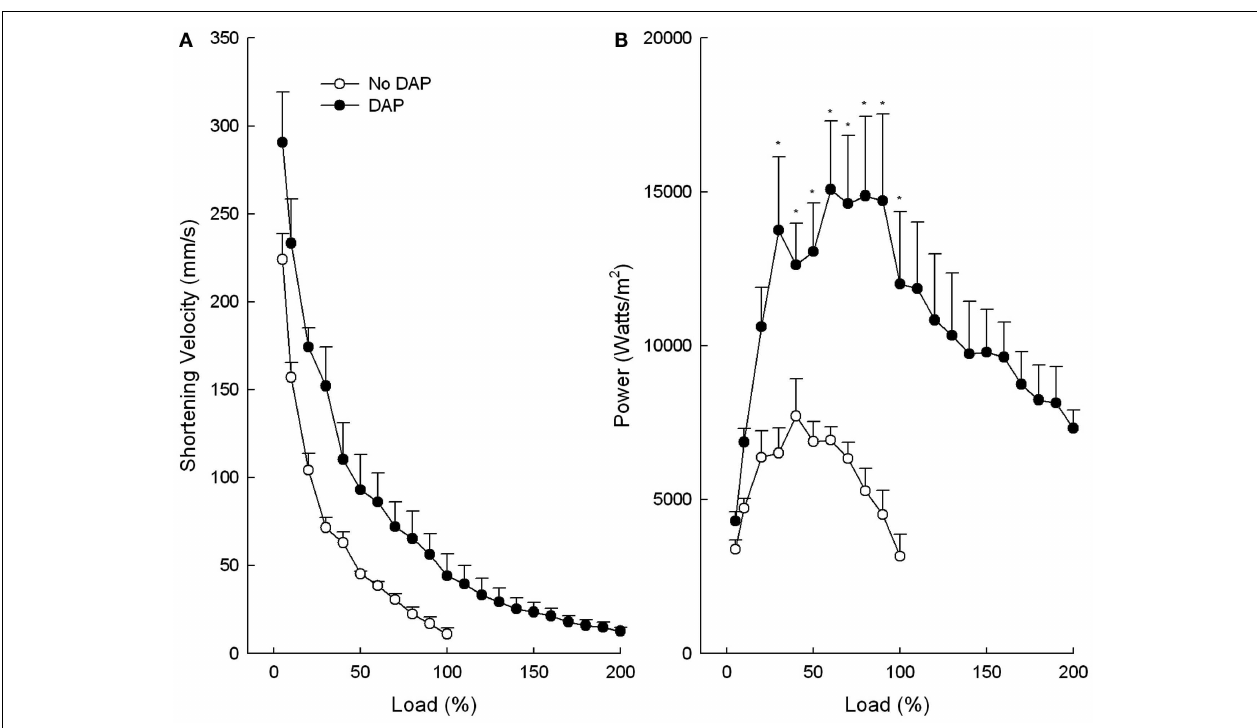
FIGURE 2 | Effects of DAP on muscle velocity of shortening (A) and power (B) during 20Hz isotonic stimulation at different loads. Load values were calculated as a function of the maximum load before the addition of DAP (or no drug).Values are means ± SE.